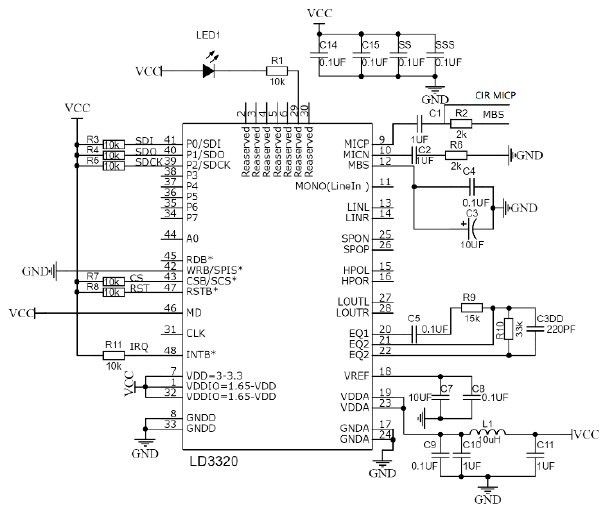
Figure 2. The schematic diagram of phonetic transcription unit.